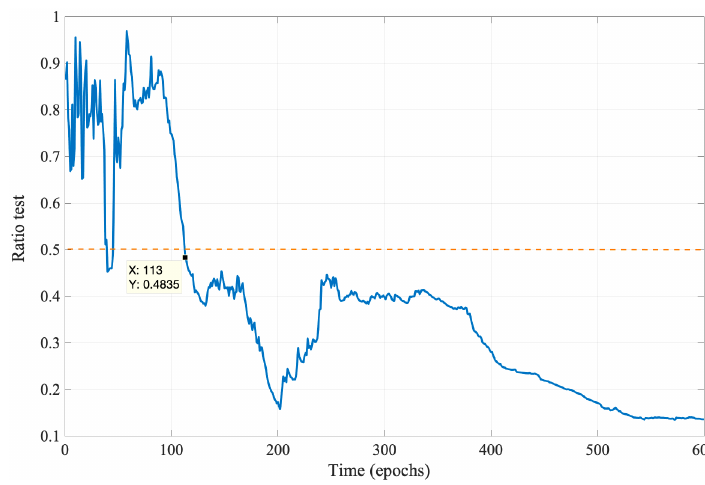
Figure 5. Test of the reliability of DD integer